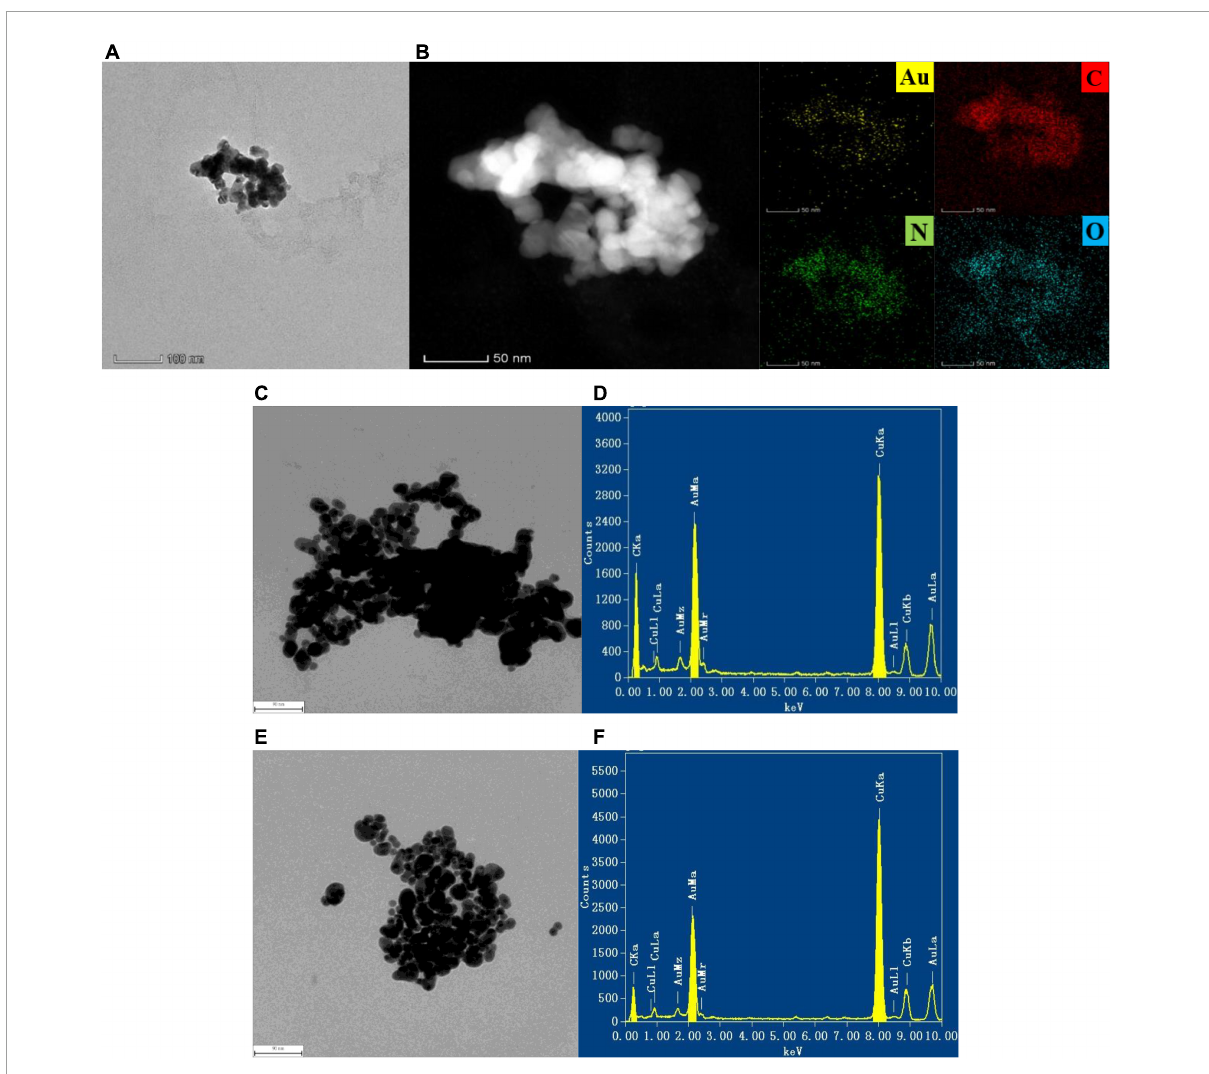
FIGURE2 TEM images of AuMOF and the analysis system, the measuring parameters were accelerating voltage = 200 kV, point resolution = 0.250 nm, tilt angle = ± 25.0 degrees. (A) TEM image of AuMOF; (B) TEM-EDS elemental mapping of AuMOF; (C) TEM image of pH 6.80 PBS + 0.750 µ mol/L BF + 0.0725 mmol/L AuNP solution; (D) EDS of pH 6.80 PBS + 0.750 µ mol/L BF + 0.0725 mmol/L AuNP solution; (E) TEM image of pH 6.80 PBS + 0.750 µ mol/L BF + 2.50 µ mol/L SO 32 − + 0.0725 mmol/L AuNP solution; (F) EDS of pH 6.80 PBS + 0.750 µ mol/L BF + 2.50 µ mol/L SO 32 − + 0.0725 mmol/L AuNP